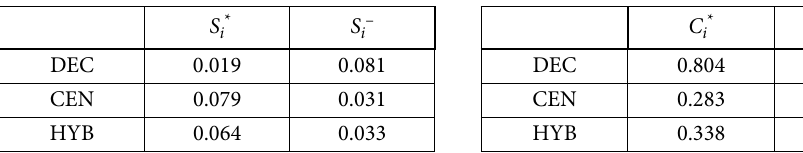
Table 12. Resultant of S i * and S i – Table 13. Summary of the TOPSIS C i